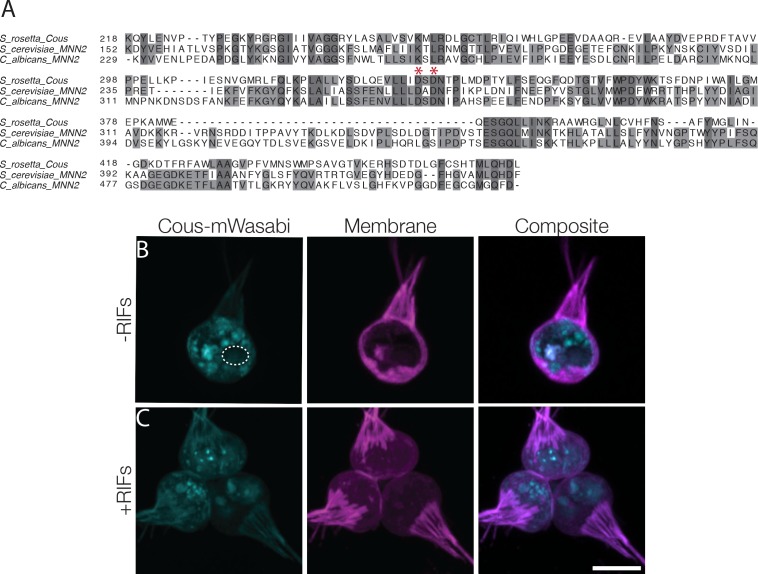
Couscous homology and localization.(A) The predicted mannosyltransferase domain from S. rosetta was aligned to the alpha-mannosyltransferase domain of MNN2 genes from S. cerevisiae (NCBI accession NP_009571.1) and C. albicans (NCBI accession XP_710276.1). Red asterisks highlight the conserved DXD motif of many glycosyltransferases. (B) The transgenes mCherry-membrane marker and Couscous-mWasabi fusion protein were expressed in wild type S. rosetta. The Couscous fusion localized to puncta distributed throughout the cell (to the exclusion of an unidentified organelle; circle) and faintly at the cell collar. Scale bar = 5 μm.